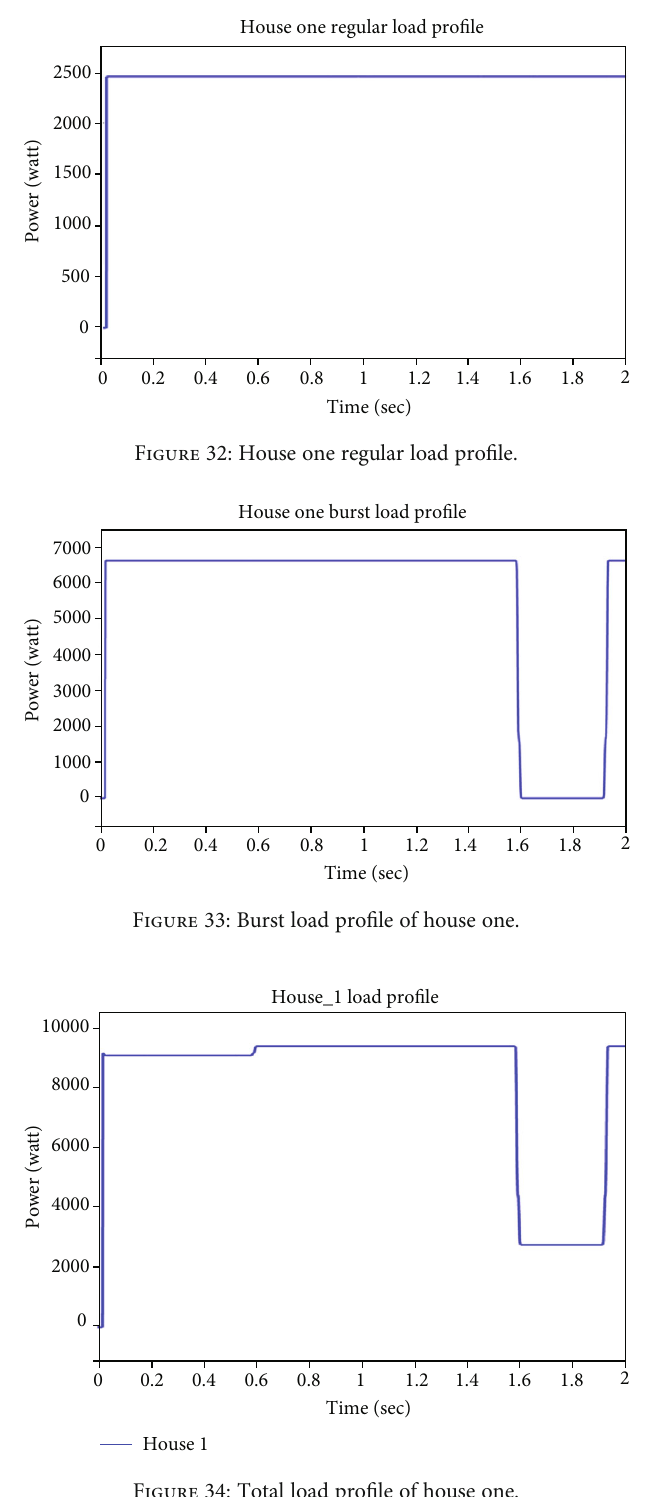
Figure 34: Total load pro fi le of house